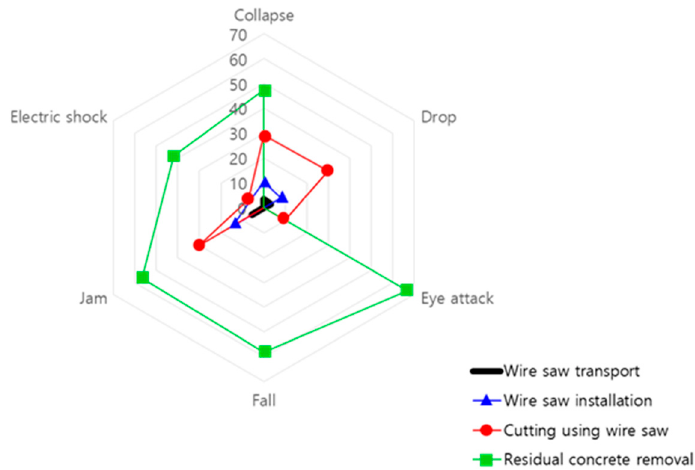
Figure 4. Integrated risk graph by work type.